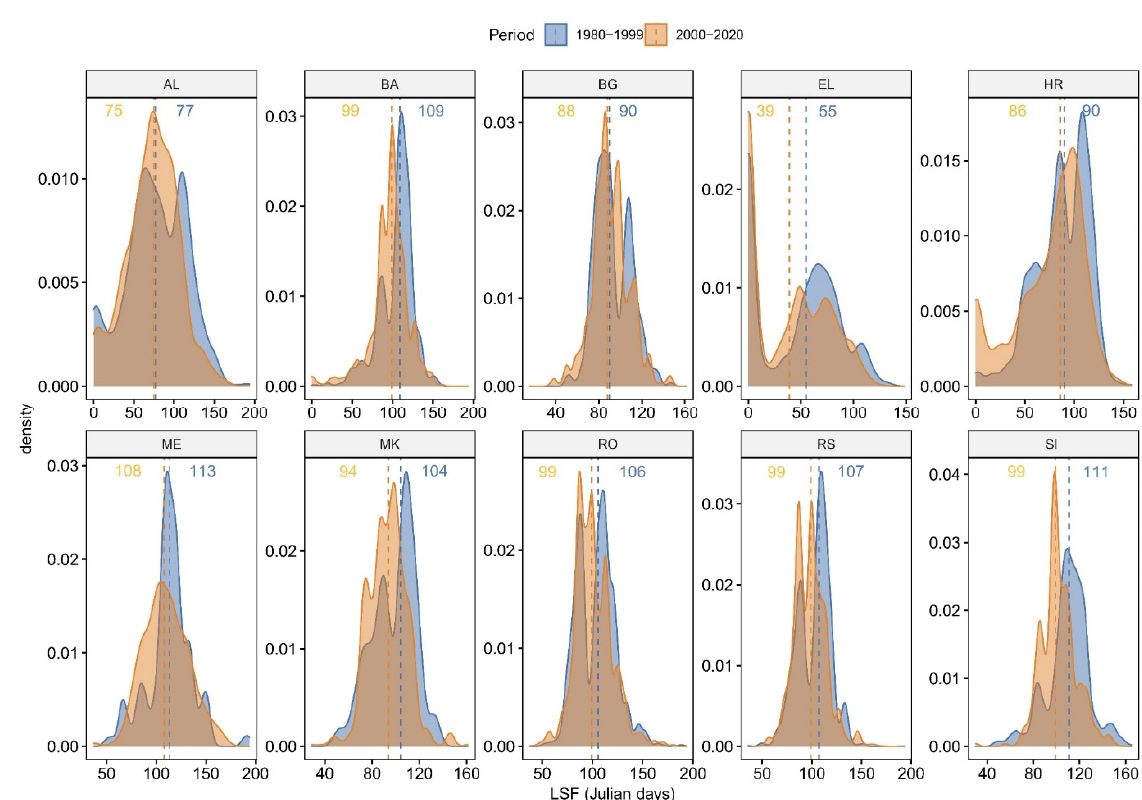
Figure 17. The last spring frost (LSF) probability density per country for the 1980–1999 and the 2000–2020 time periods, with the medians (line).